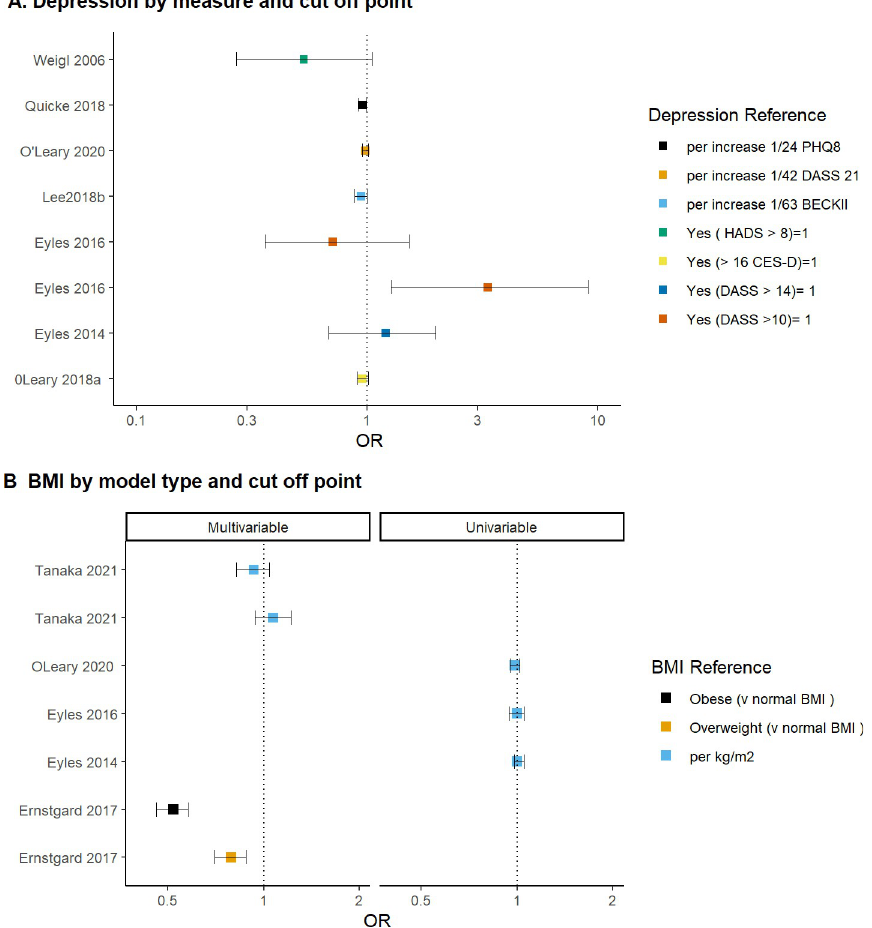
Fig 4. Effect of depression and increased BMI on the odds of positive response following a combined first-line intervention for knee osteoarthritis. Graph reports the log odds ratio and 95% CI. Repeated study labels by the same author represent multiple responder definitions within each study. Graph plots the odds ratio for the probability of BMI or presence of depression on a positive response following intervention. For BMI, OR > 1 = increased probability of being a responder with increased BMI. For depression, OR > 1 = increased probability of being a responder with the presence of depression. For a continuous predictor, we interpret the odds ratio per one unit change, and for a dichotomised predictor, the OR is the probability compared to the reference group. For depression, original data from 7 studies (5 cohorts) reporting OR. Studies not included: 1 reporting a regression coefficient [42] and 2 mean difference [37, 41]. For BMI, original data from 5 cohort studies reporting OR. Studies not included: 1 reporting regression coefficient [25], 2 MD [16, 37] and 1 unadjusted HR [36]. HADS = Hospital Anxiety Depression scale, PHQ-8 = Patient Health Questionnaire, BECKII = Beck Depression Inventory, DASS21 = Depression and Anxiety Stress scale, CES-D = Centre for Epidemiologic Studies Depression scale.